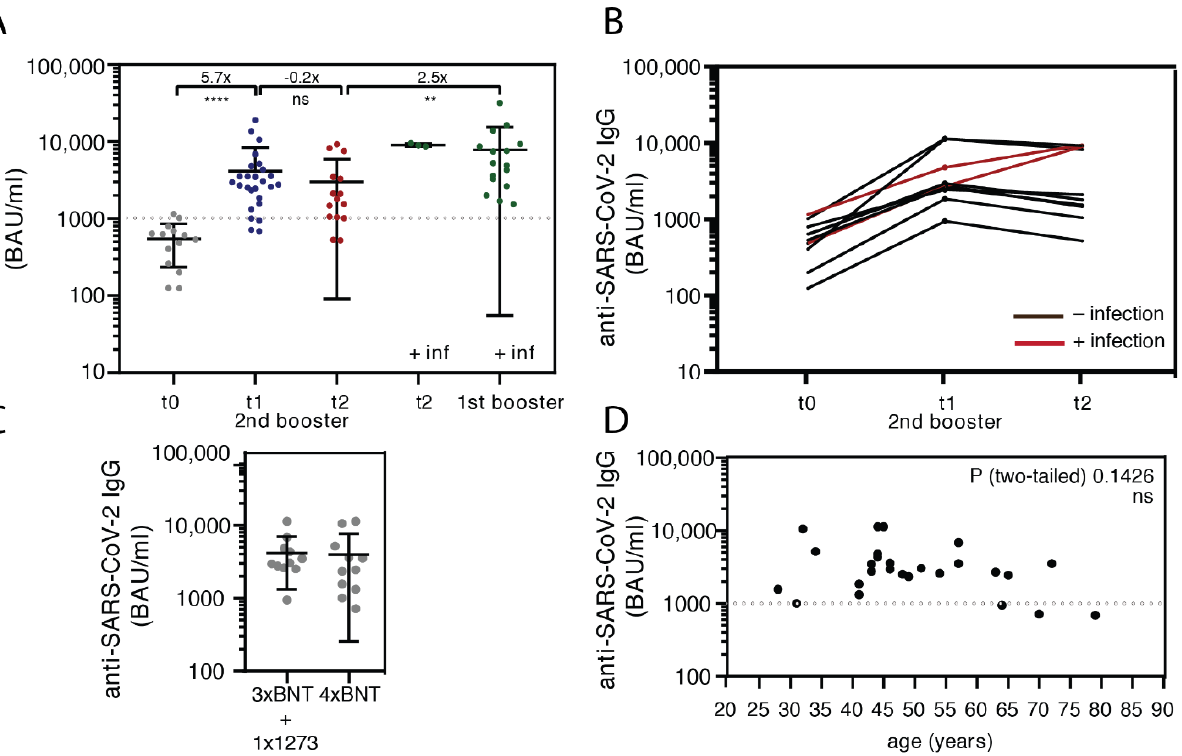
Figure 2. Characterization of the anti-Spike IgG antibody response after the second booster vaccination or after SARS-CoV-2 infection after booster vaccinations. ( A ) Anti-SARS-CoV-2 IgG levels were determined and indicated as binding antibody units per milliliter (BAU/mL) in samples before the second booster (t0), 2 weeks (t1), 7.3 weeks (t2), or infection after the first or second booster (unpaired, non-parametric, Mann–Whitney, t0 vs. t1 p < 0.0001 (indicated as ****); t1 vs. t2 ns, t2 vs. 1st booster + infection p < 0.0063 (indicated as **); error bars mean+/ − SD), ns = non-significant. ( B ) Individual responses of 8 individuals after the second booster vaccination and 2 after the second booster followed by a SARS-CoV-2 infection are plotted. ( C ) Anti-SARS-CoV-2 IgG levels dissected between the most common immunization schemes in Germany in 2021 (3 × BNT162b2 and 1X mRNA- 1273 and 4x BNT162b2) (unpaired, non-parametric, Mann–Whitney, ns—not significant, error bars mean+/ − SD). ( D ) The correlation between age and IgG levels does not show any significance (linear regression—not significant). Abbreviations: BNT = BNT162b2; 1273 =